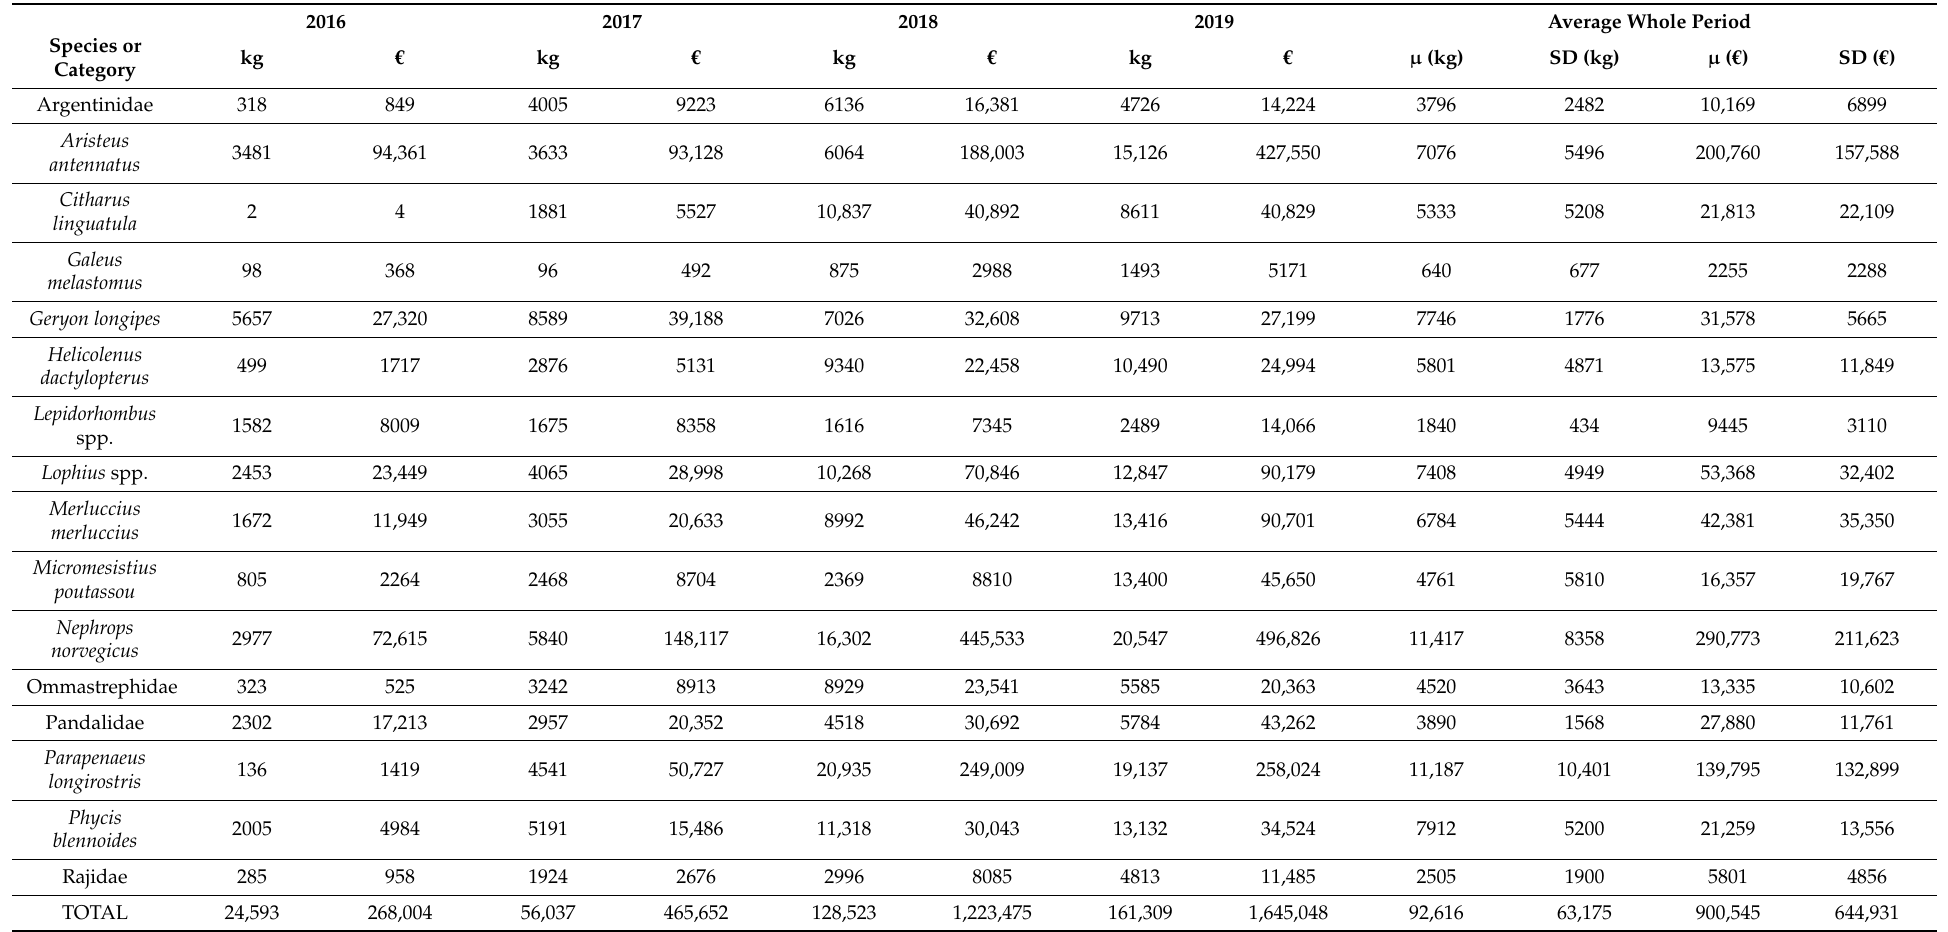
Table 4. Estimated annual landings, in terms of biomass (kg) and economic value ( € from first sale), for the main species or commercial categories extracted from the three bottom trawl fishing grounds in adjacent bottoms of the Ses Olives and Ausias March seamounts in the Mallorca Channel (Balearic Islands, western Mediterranean), and average values ( ± standard error) during the period 2016–2019. The location of these fishing grounds is shown in Figure